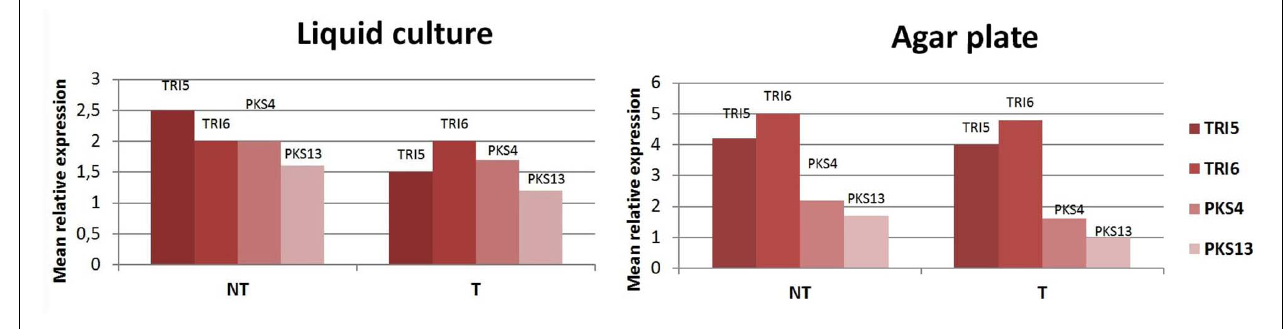
FIGURE 5 | Mean relative expression levels of TRI5 , TRI6 , PKS4 , and PKS13 after culturing Fusarium culmorum in submerged cultures and on agar plates. T , F. culmorum cultures exposed to thymol at a sensitizing concentration of 50 ppm; NT , non-exposed